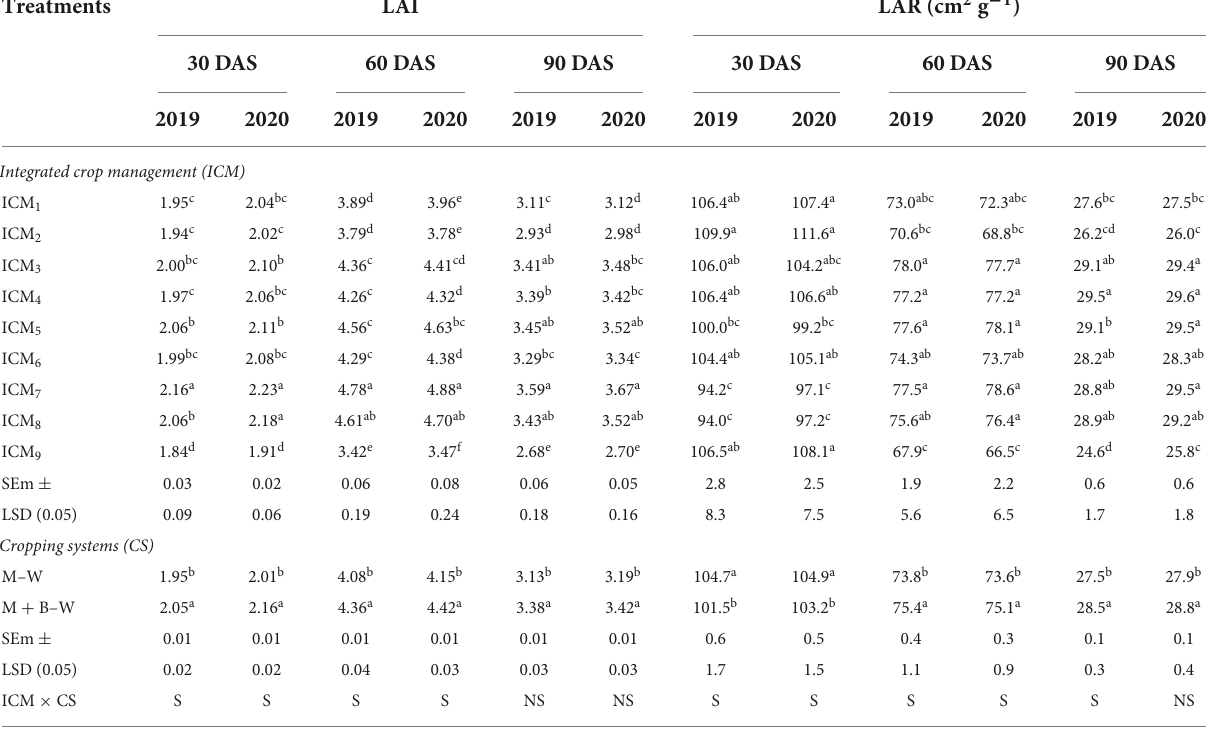
TABLE 8 Effect of ICM modules and cropping system on leaf area index (LAI) and leaf area ratio (LAR) of maize at 30-days interval a .